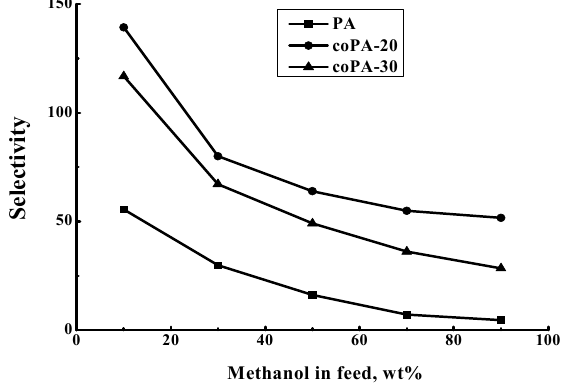
Figure 9. Dependence of selectivity β Methanol-Toluene on methanol concentration in the feed for the pervaporation of a methanol–toluene mixture, 20 ° С .